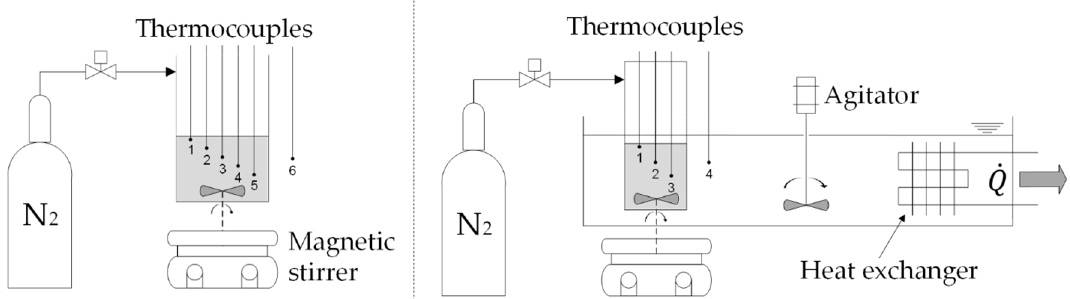
Figure 1. Setup for the polymerizable bicontinuous microemulsion (PBM) controlled radical polymerization investigation using temperature